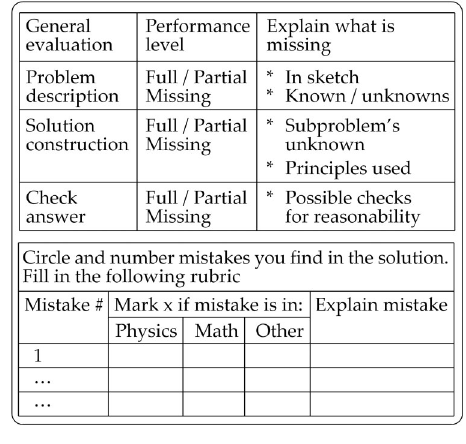
FIG. 3. Self-diagnosis rubric.